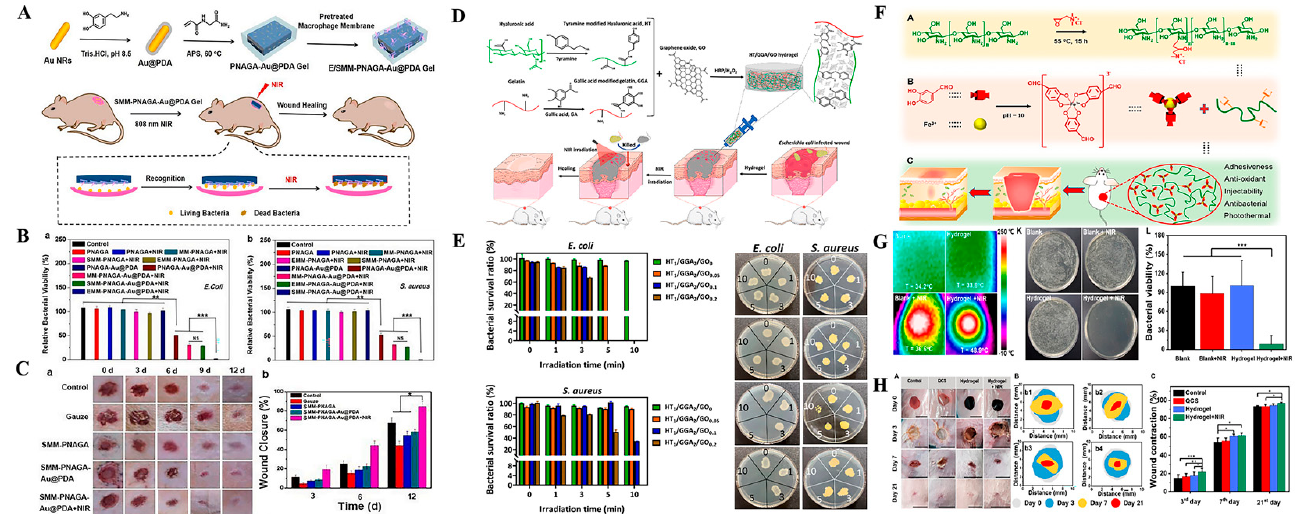
Figure 7. Nanocomposite hydrogel wound dressings with efficient photothermal bactericidal per- formances for the treatment of infected wound. ( A ) Schematic illustration of a dopamine-coated Au